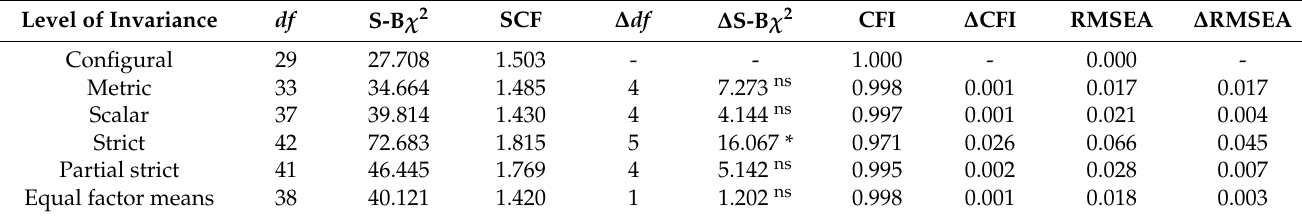
Table 1. Dyadic measurement